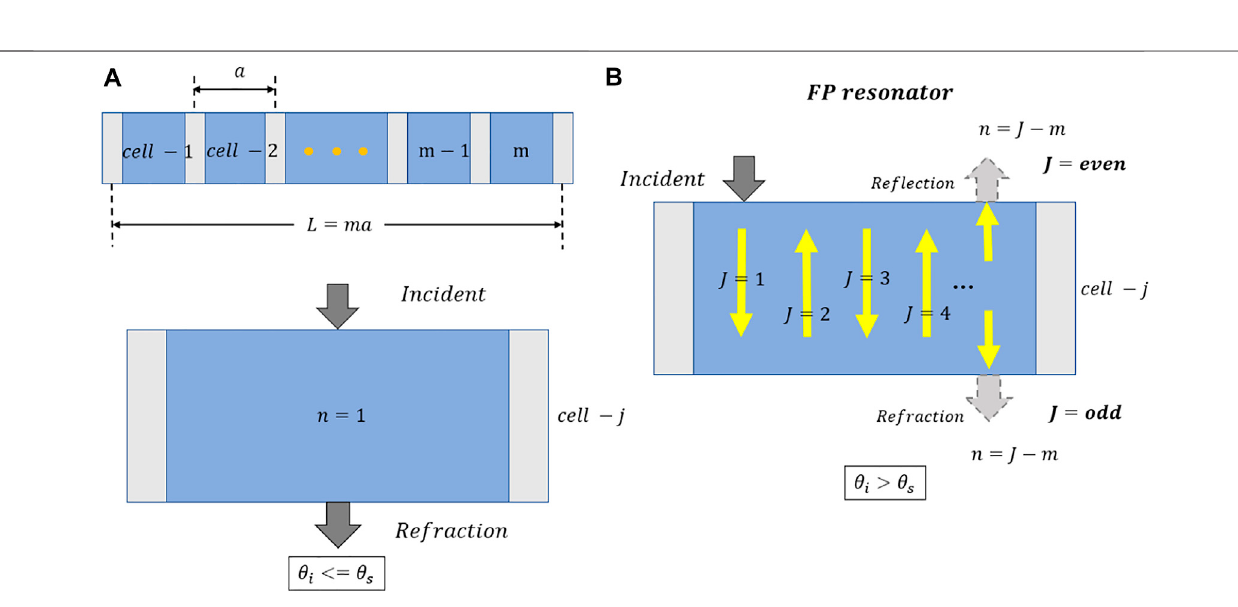
Frontiers in Physics |